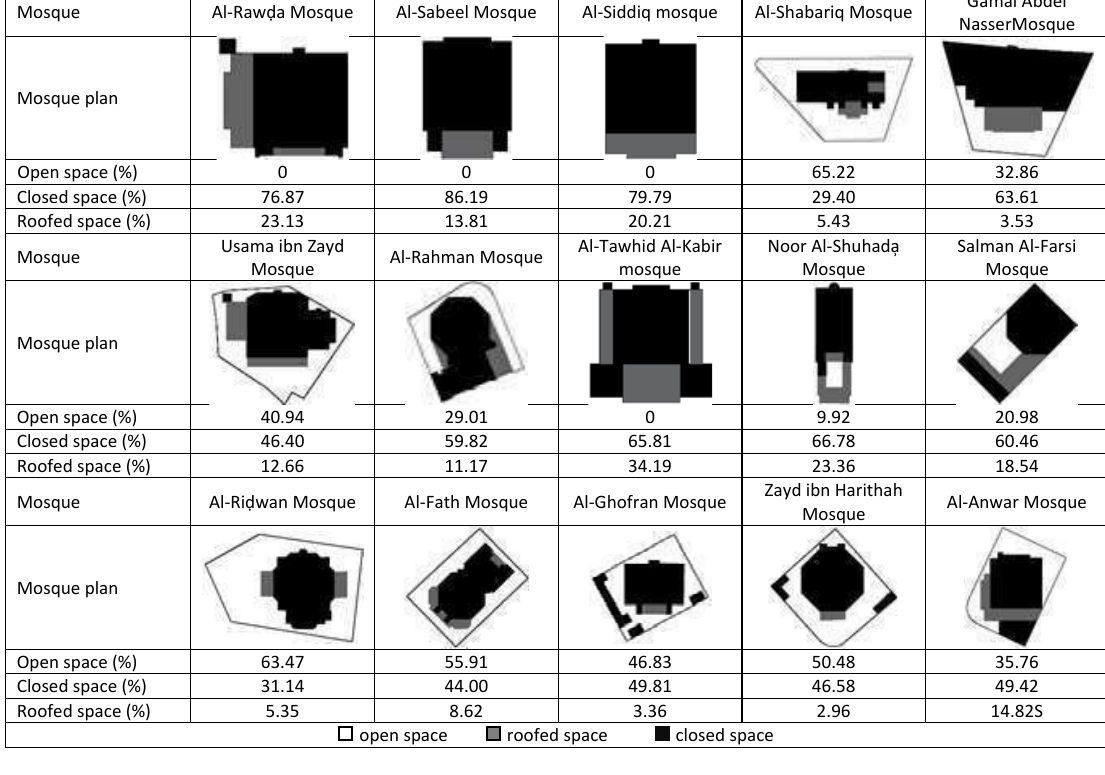
Table 3: The shares of open, closed, and roofed spaces in the total area of contemporary mosques Mosque